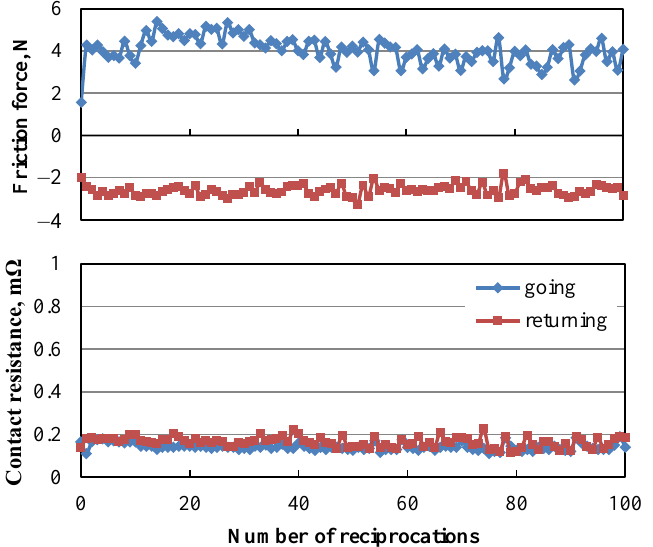
Figure 6. Changes in the frictional force and the contact electrical resistance ( t = 0.64 mm, Ag plating 5 µm, v = 200 mm/min).